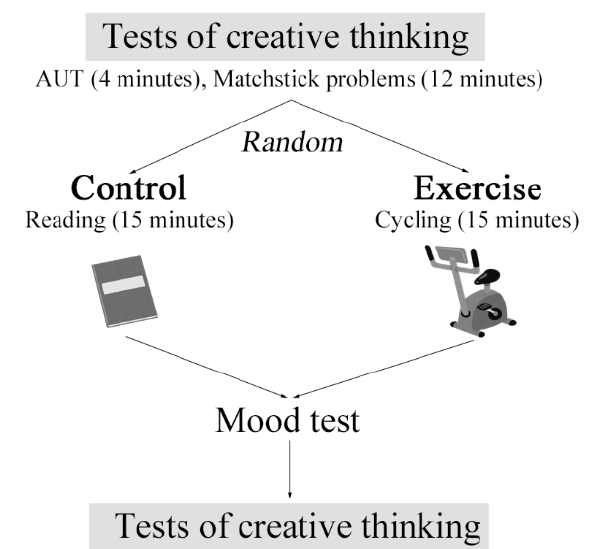
Figure 1. Schematic illustration of the study design.